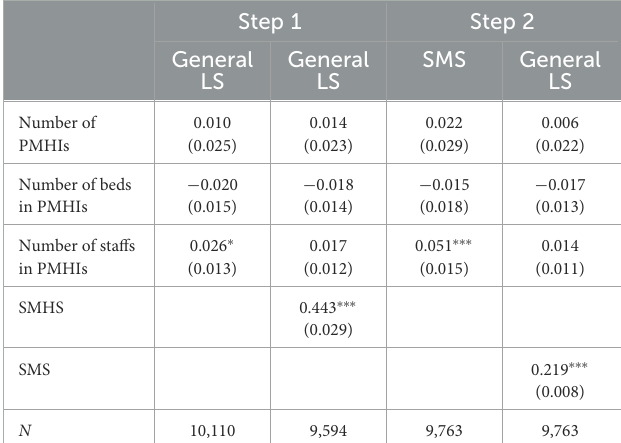
TABLE 3 Robustness